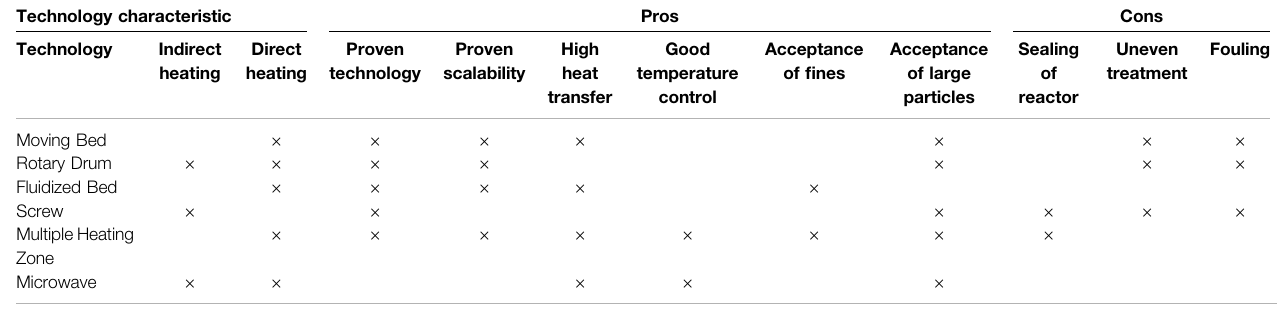
TABLE 2 | Various torrefaction designs and qualitative assessments (Ghiasi, 2019).